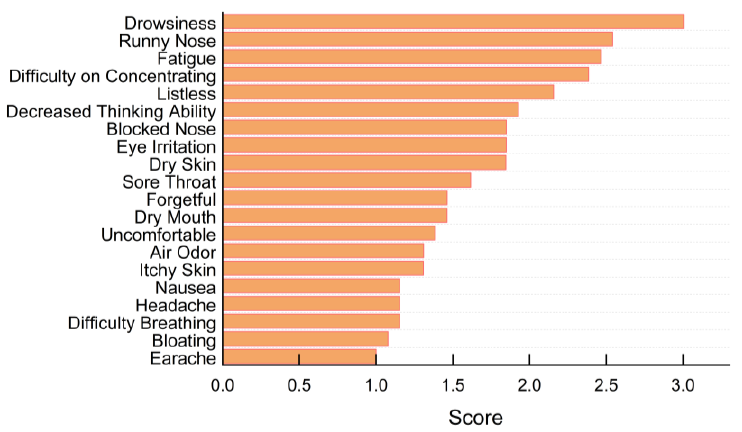
Figure 10. Average score distributions of health